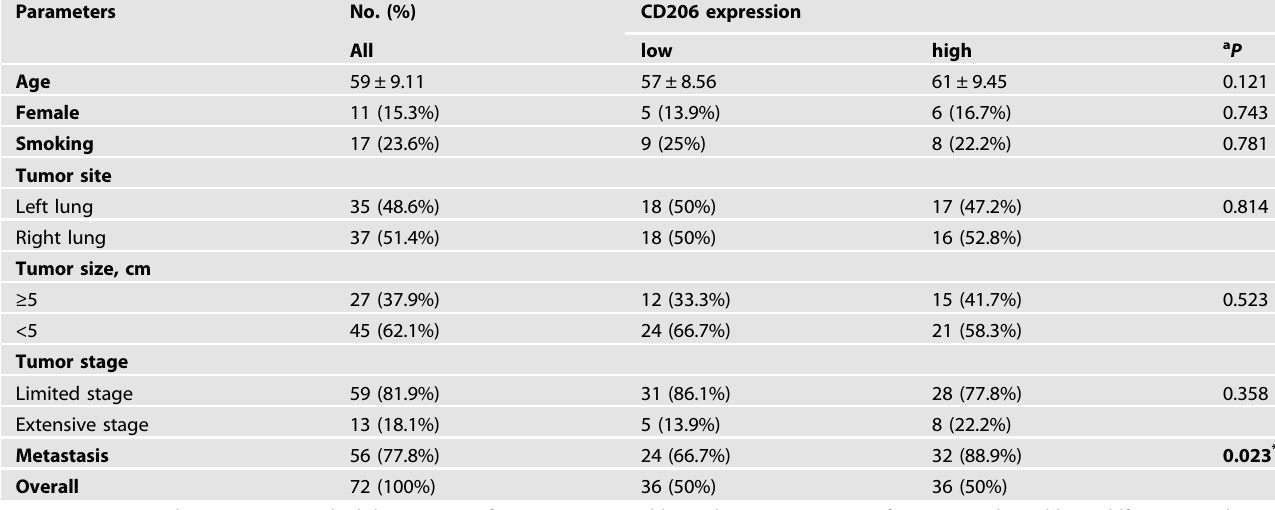
Table 1. Correlation between the CD206 + TAMs and clinical parameters ( n =